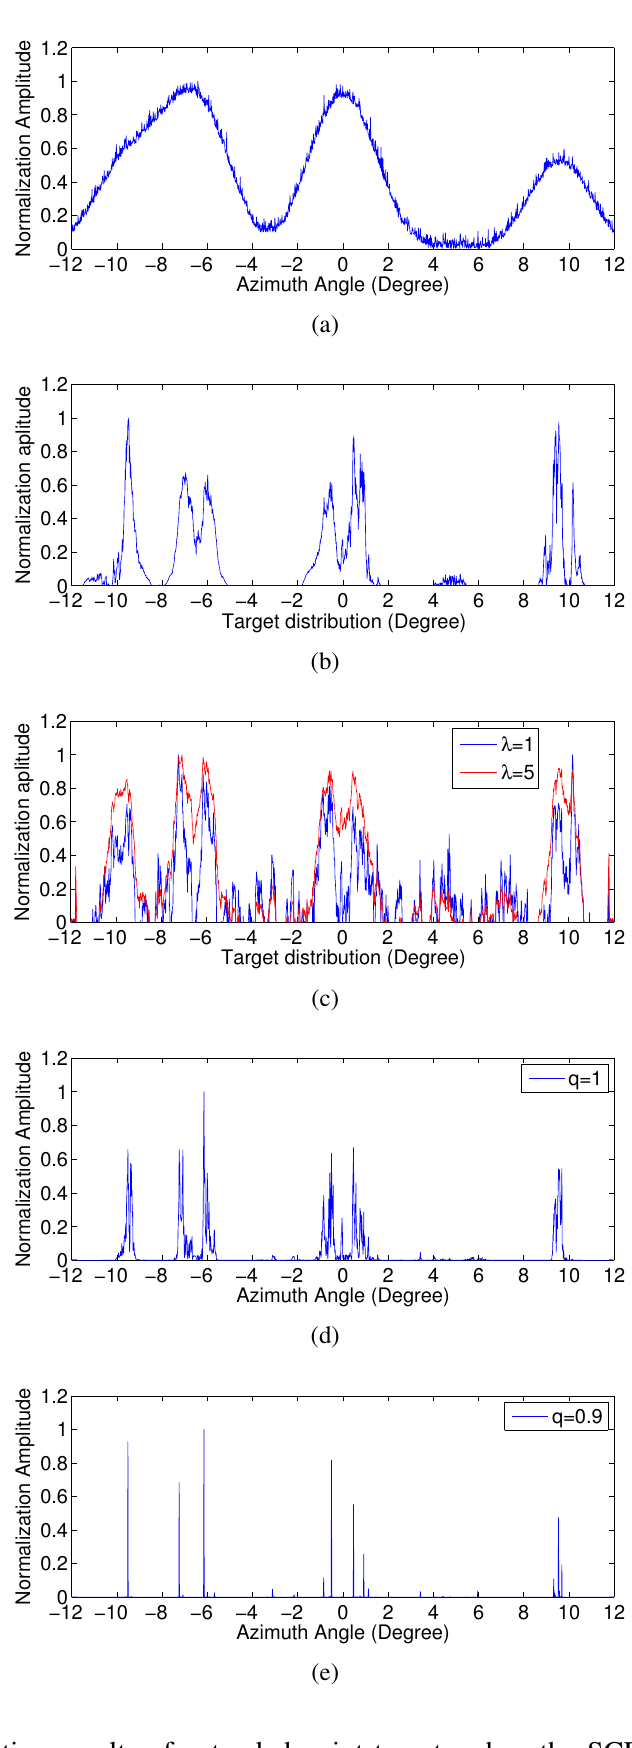
Figure 4. Simulation results of extended point targets when the SCR is 20 dB. ( a ) Real aperture signal. ( b ) RL algorithm. ( c ) Tikhonov regularization with different regularization parameters. ( d ) Proposed algorithm when q = 1 . ( e ) Proposed algorithm when q = 0 . 9